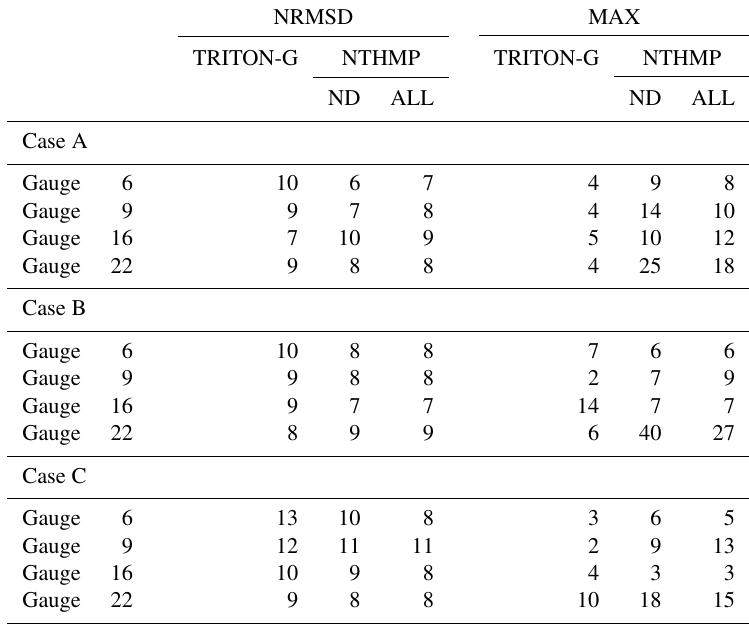
Table A3. Water level time series TRITON-G model errors with respect to laboratory experiment data for cases A–C. Mean values obtained for the performing NTHMP models are separated in non-dispersive models (ND) and non-dispersive and dispersive models together